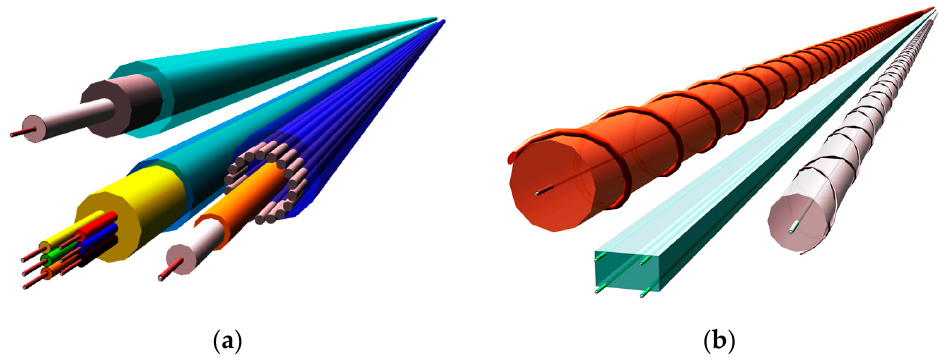
Figure 14. Spatial visualisation of example ( a ) layered cables; ( b ) monolithic sensors.